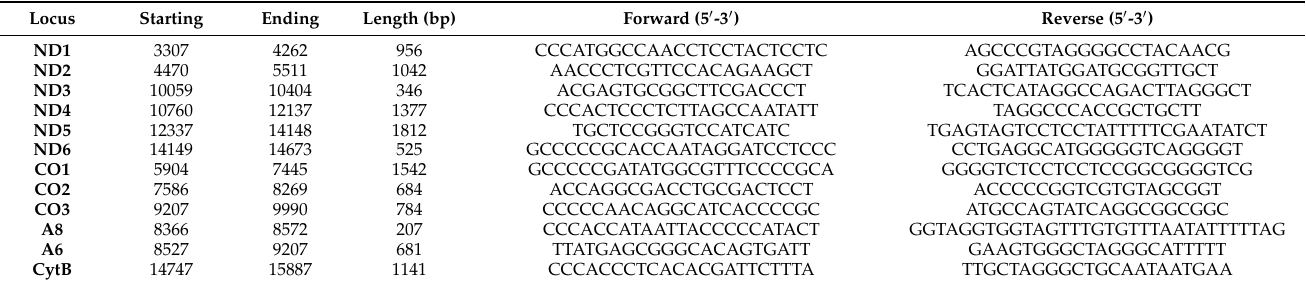
Table 1. Oligonucleotide primers for mtDNA